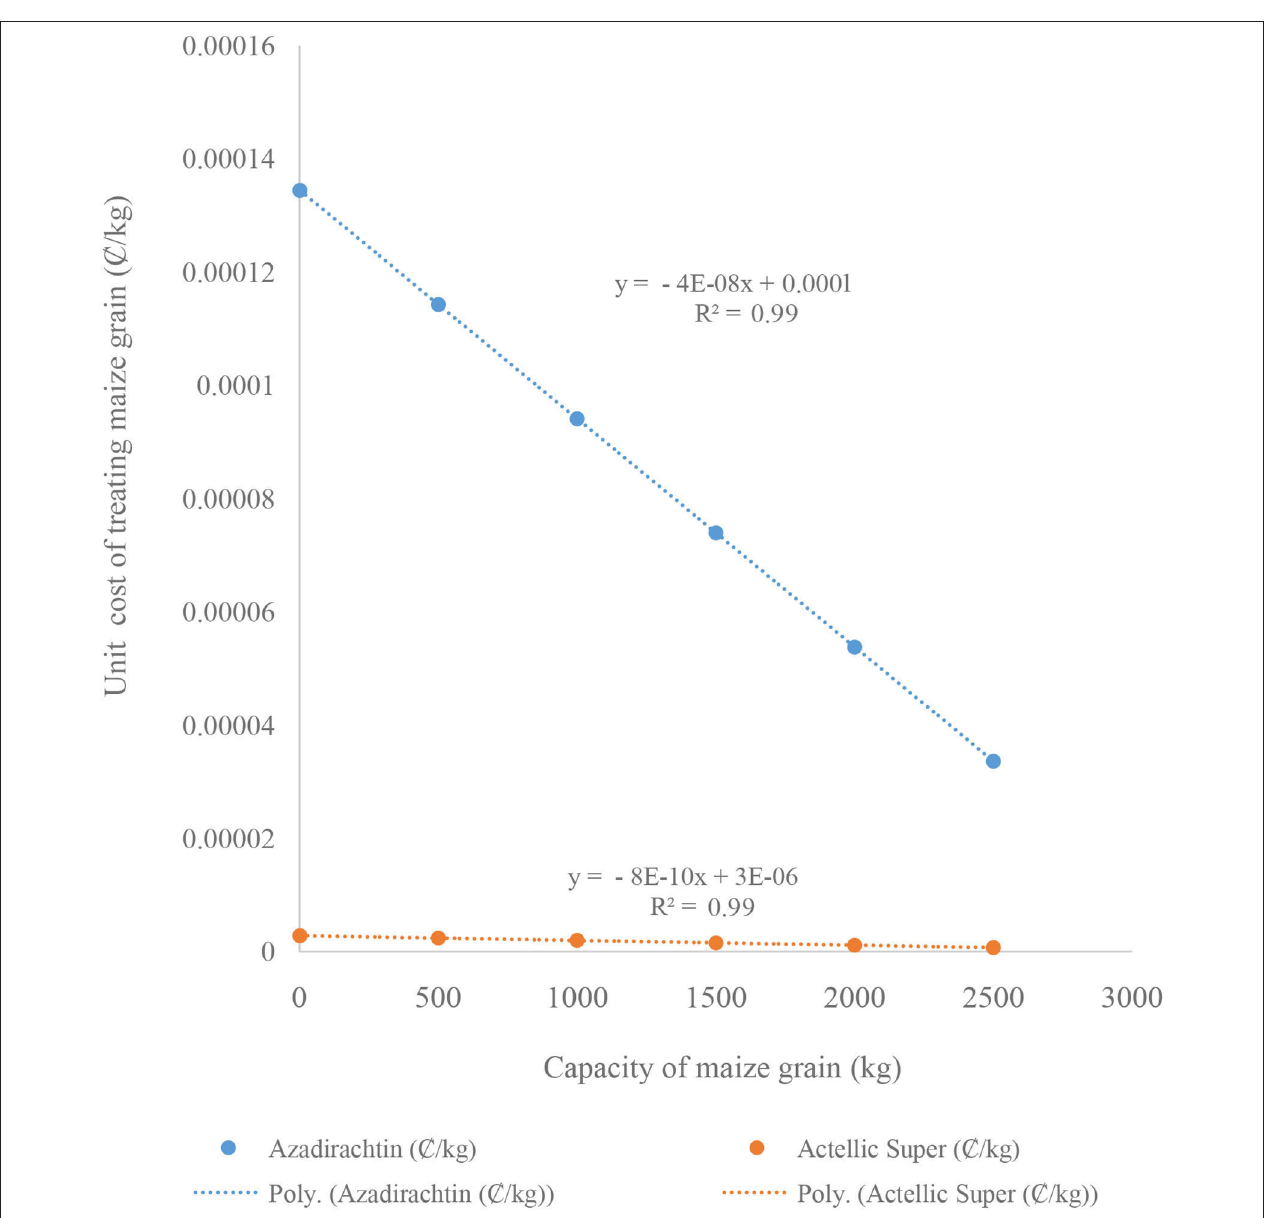
FIGURE 8 | The unit cost of treating maize grain in Ghana (economies of scale) (generated using Microsoft